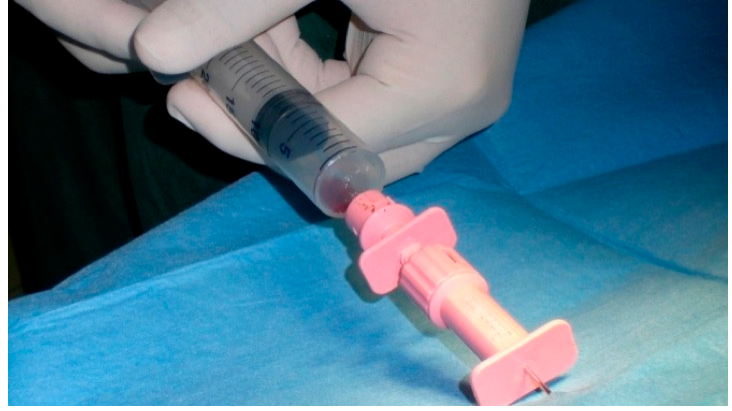
Figure 1. Bone marrow collection from the iliac crest.